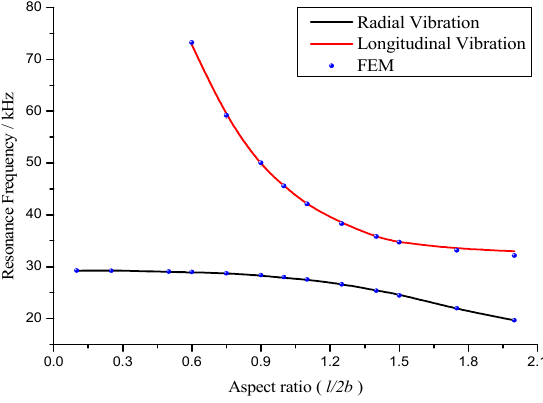
Figure 1. The relationships between resonance frequency and aspect ratio.